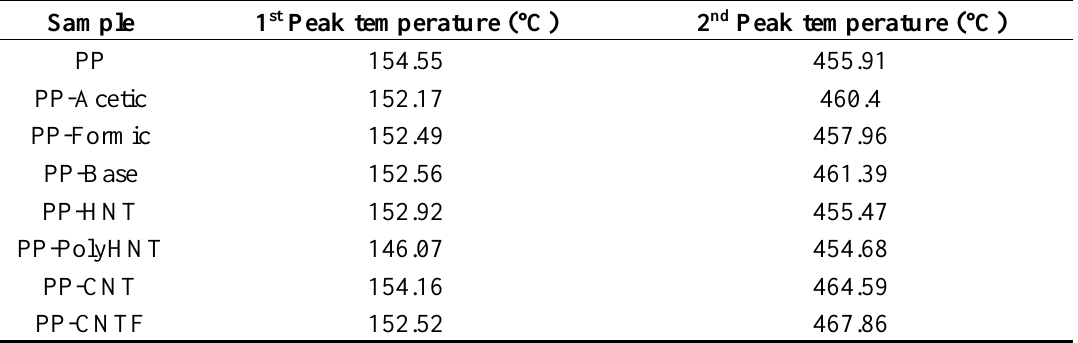
Table 5. Temperatures where first peak appear in DSC referring to melting temperature.